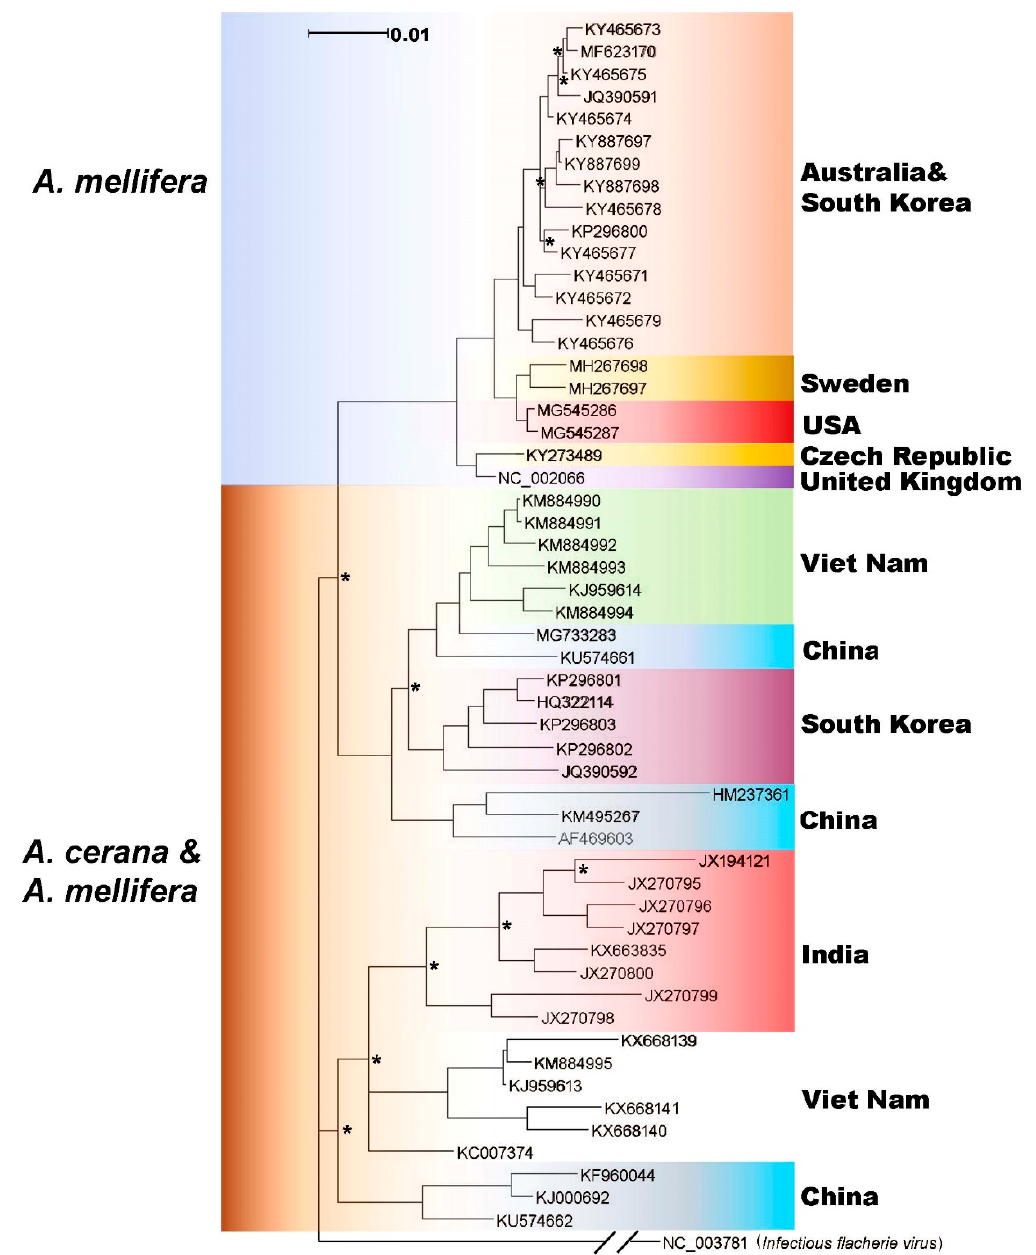
Figure 3. Phylogenetic tree of tree of the translated polyprotein. SBV sequences were retrieved from GenBank, and the translated polyproteins were aligned using MUSCLE. The phylogenetic tree was inferred by using MrBayes, and the analysis parameters were set to estimate relationships using mixed phylogenetic models. Infectious flacherie virus (IFV, GenBank accession: NC_003781.1) was used as an outgroup to root the trees. Tree branches are colored by isolation host on the left, and country of isolation on the right. In some cases, isolates from multiple countries were intermingled, and are shown using the same color (e.g., Australia and South Korea). Nodes that are not supported with clade credibility values >=90 are marked with *.